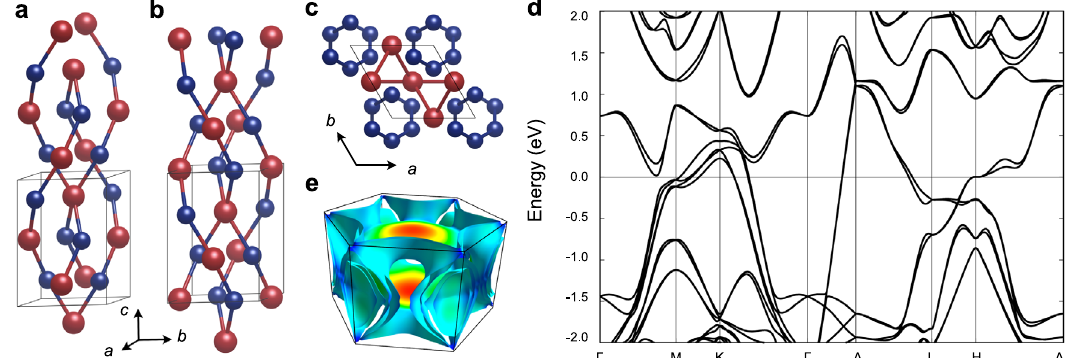
Fig. 3 Structure and electronic properties of chiral TaSi 2 . a Side view of the right-handed TaSi 2 (SG 180). Ta atoms are denoted as red and Si atoms as blue balls. b Top and side view of the left-handed TaSi 2 (SG 181). c The calculated Fermi surface ( E = E F ) consists of four nested sheets. The color scheme re fl ects the Fermi velocity 57 . d Band structure calculated along the high-symmetry lines in the momentum space. The high-symmetry points are consistent with the labels in Fig. 1.